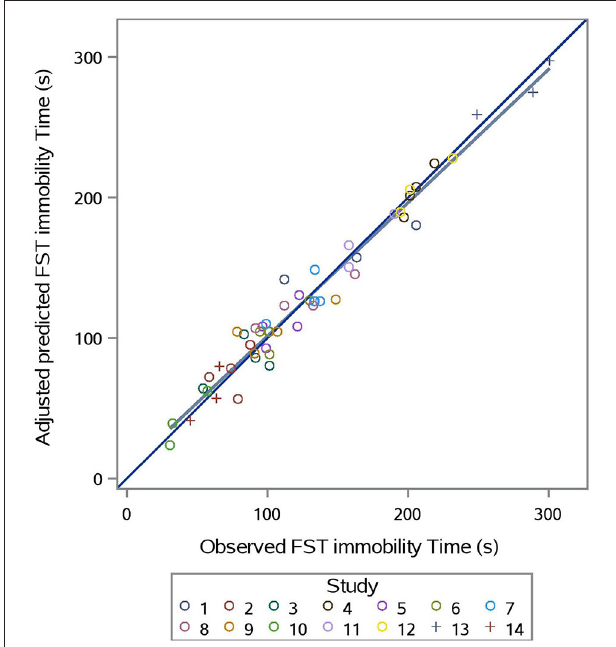
FIGURE 7 | Adjusted predicted vs. observed FST immobility time (s) for prediction equation used in Model 3